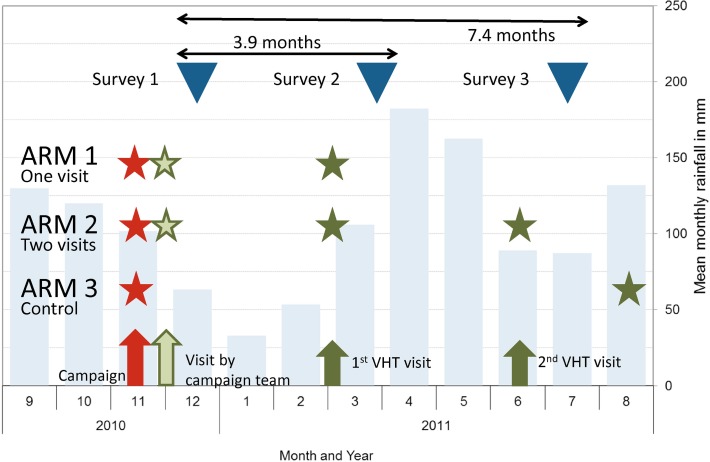
Rainfall pattern for Kamuli District and timing of study activities.Light blue bars represent monthly rainfall; red = LLIN mass campaign; green = interventions; stars show which timing of activities per study arm.